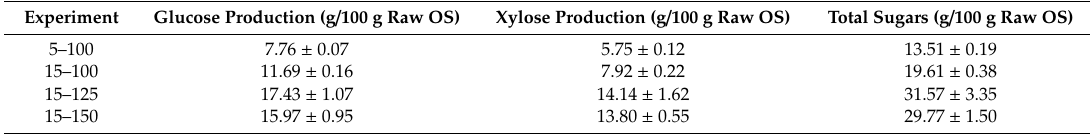
Table 5. Overall glucose, xylose and total sugars production per 100 g of raw olive stone.